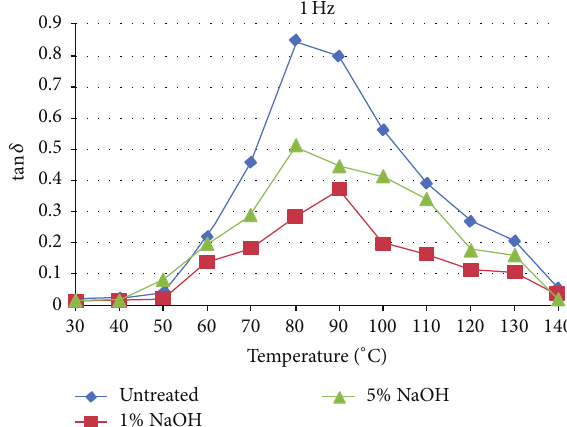
Figure 2: tan 𝛿 versus temperature curves of the alkali treated and untreated composites at 1Hz frequency